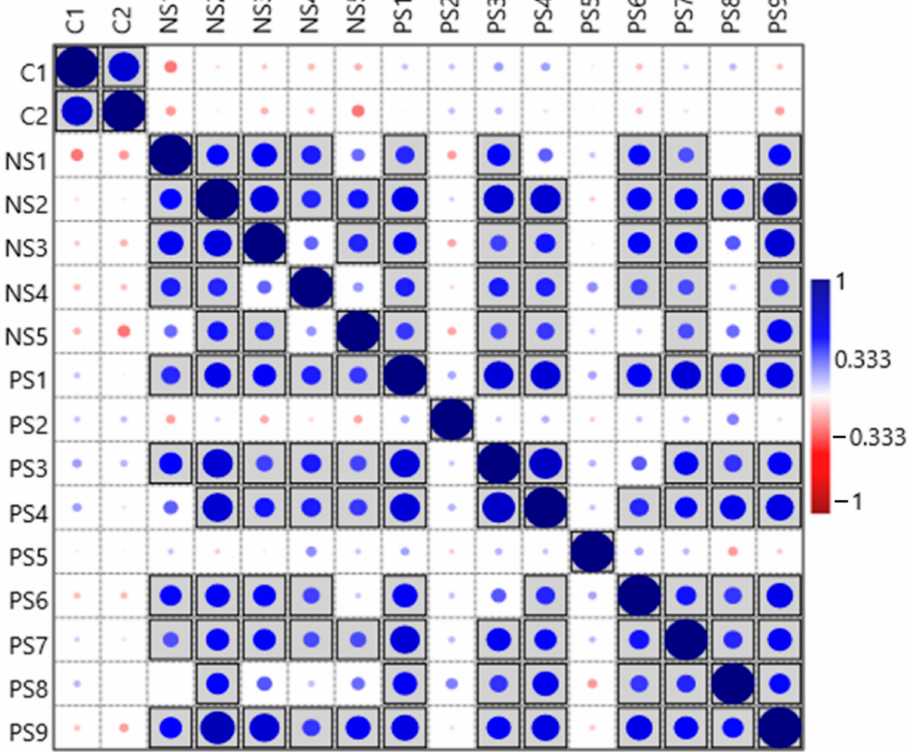
Figure 4. Correlation plot between samples from explosives contaminated (SITE1 and SITE2) and agricultural soil (C1, C2) at genus level. Correlation plot was based on Spearman rank correlation. Grey highlighted squares represent significance, p ≤ 0.005. Filled circles (size) represent correlation between the samples. Image was constructed in PAST software